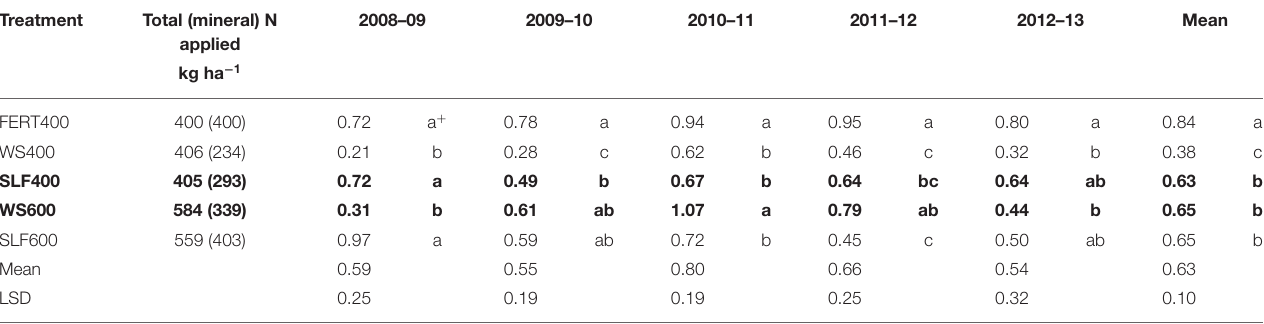
TABLE 5 | Mean N 2 O-N emission factors for whole slurry, separated liquid fraction, and mineral fertilizer applied to perennial grass over a 5 year period in south-coastal BC, Canada.